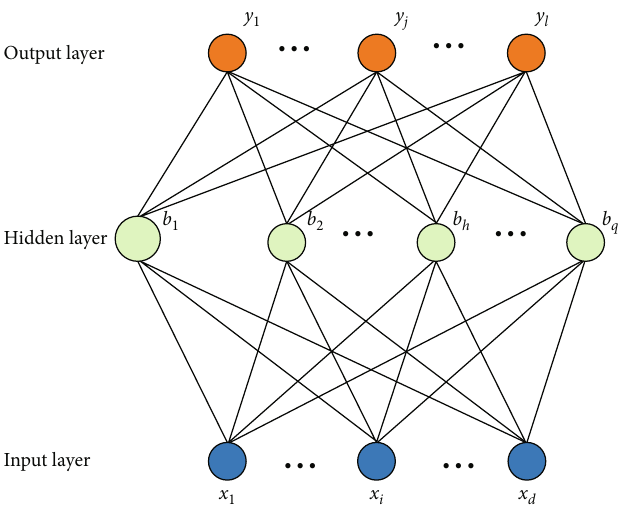
Figure 2: Schematic diagram of basic structure of